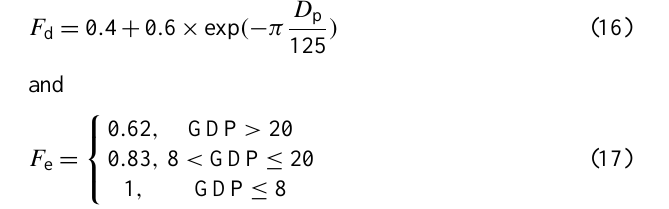
Fig. 7. Same as Fig. 6, but for tree-dominated regions outside tropi- cal closed forests. Goodness of fit is R 2 = 0 . 43 ( n = 9) in (a) . F e in (b) reproduces that a MODIS , GFED /F d in tree-dominated regions of GDP > 20k1995US$capita − 1 and GDP > 8k1995US$capita − 1 is 0.62 and 0.83 of that in other tree-dominated